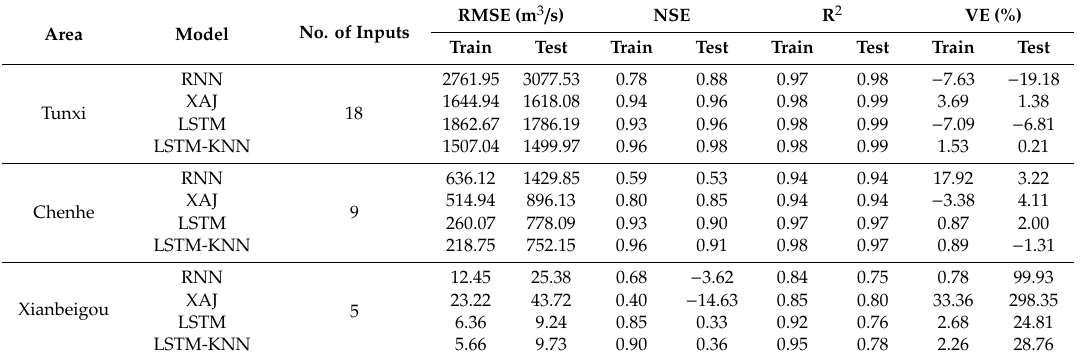
Table 1. Statistics of flood